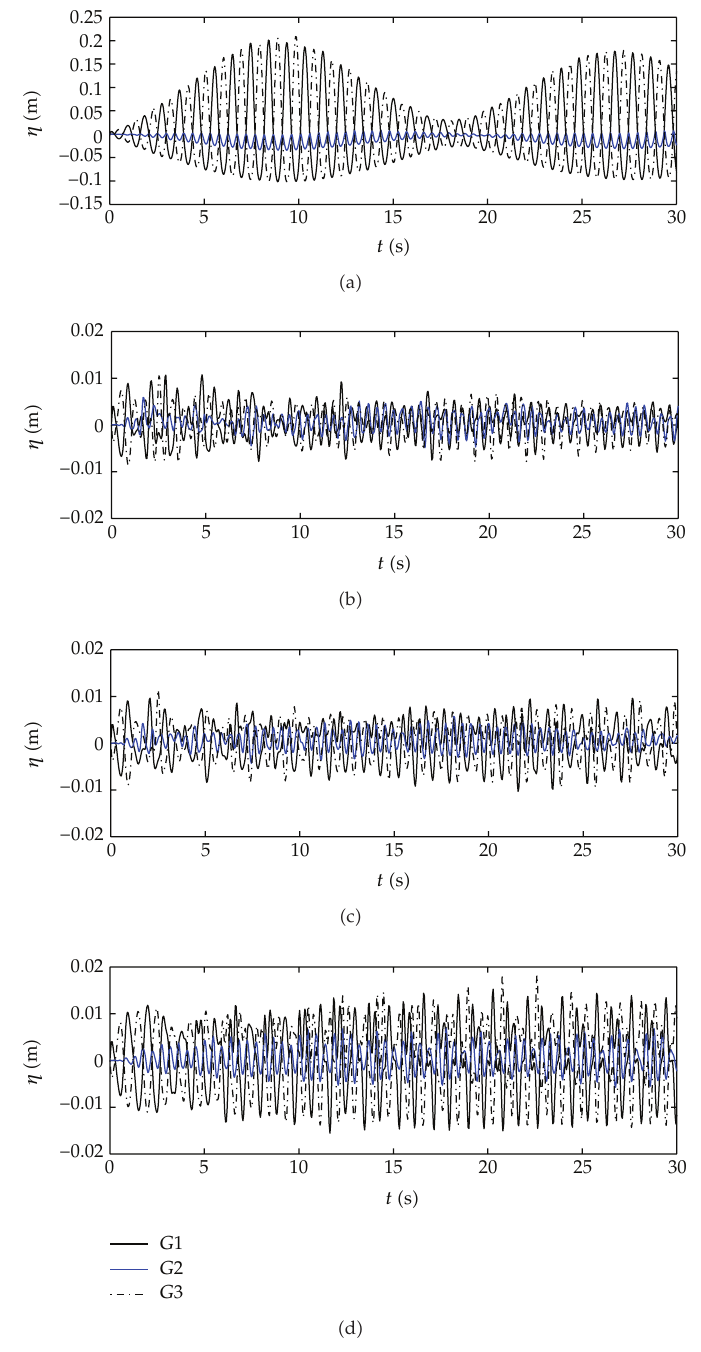
Figure 10: Comparisons of the free surface elevation at three wave gauges among the di ff erent ba ffl e arrangements under the excitation of ω (cid:9) 6 . 8636rad/s (cid:6)(cid:6) a (cid:7) without ba ffl e; (cid:6) b (cid:7) b (cid:9) 0mm; (cid:6) c (cid:7) b (cid:9) 40mm; (cid:6) d (cid:7) b (cid:9) 80mm (cid:7)